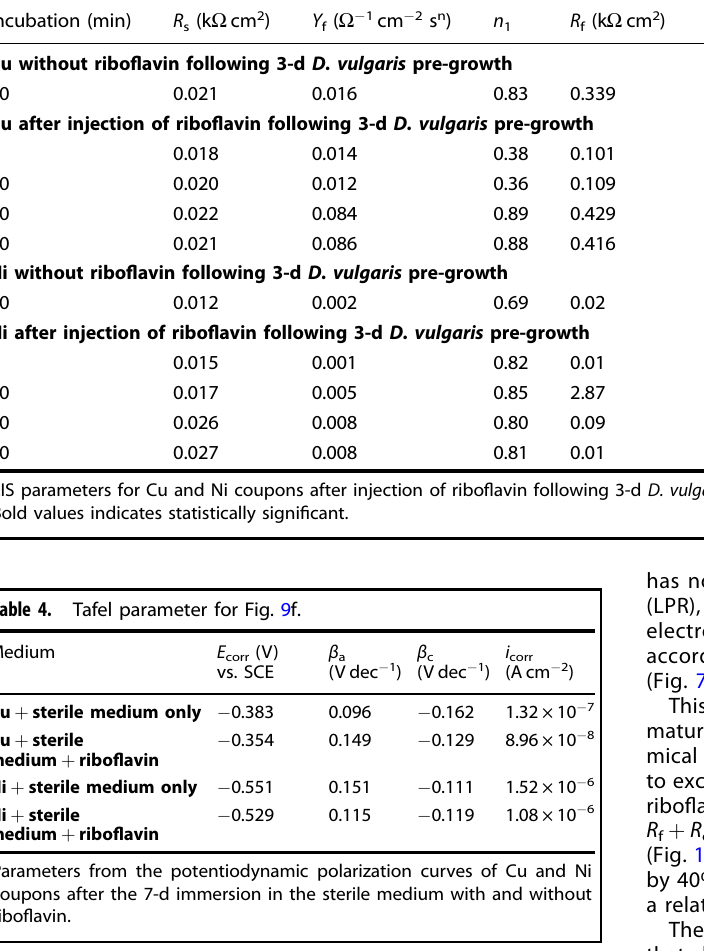
Fig. 6. About 20 ppm (w/w) ribo fl avin accelerates Ni MIC but not